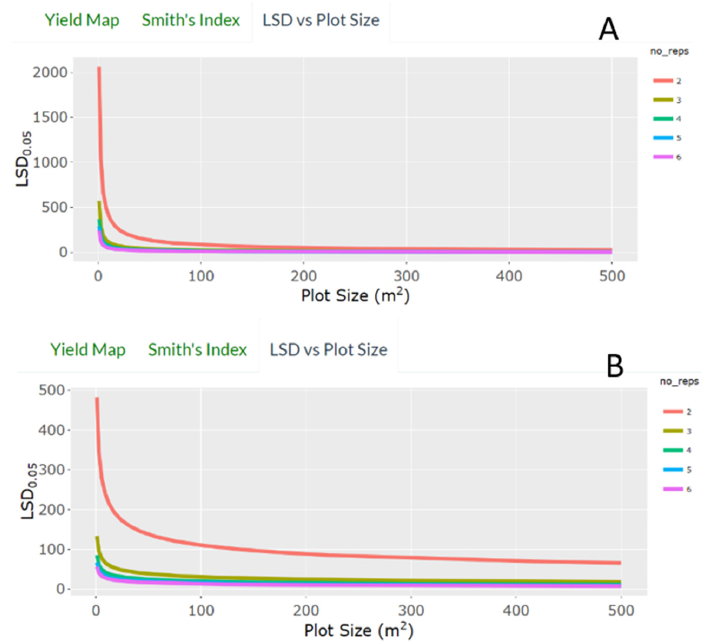
Figure 7. Output from a Shiny application to automate data compilation for uniformity trials. The output data include the regression of least significant difference on plot size for trials with two, four, or six replicates. Fields ISU.B4 ( A ) and ISU.SE ( B ) are used in this example. Relationship of Variance and Plot Size. Available online: https://marin-harbur.shinyapps.io/plot_size_app_for_uploaded_data/ (accessed 18 June 2021).